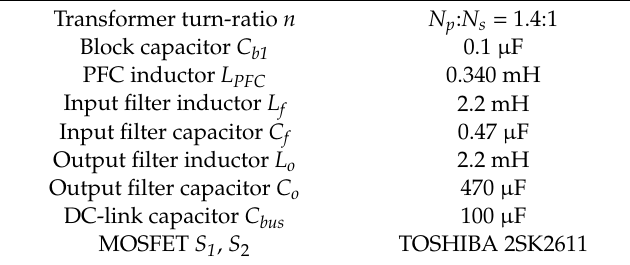
Table 2. Component parameters.